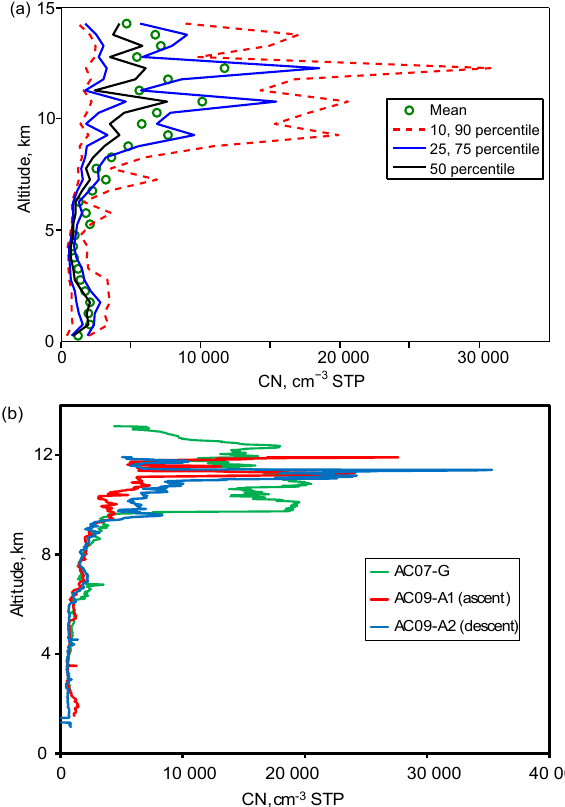
Figure 6. Trajectory statistics based on (a) 72h and (b) 120h back trajectory calculations for September 2014, initialized at Manaus at an elevation of 12km. Figure 7. Vertical profiles of CN concentrations, N CN ; (a) overall statistics from all flights, (b) examples from individual profiles on flight AC07 (segment G) and AC09 (segments A1 and